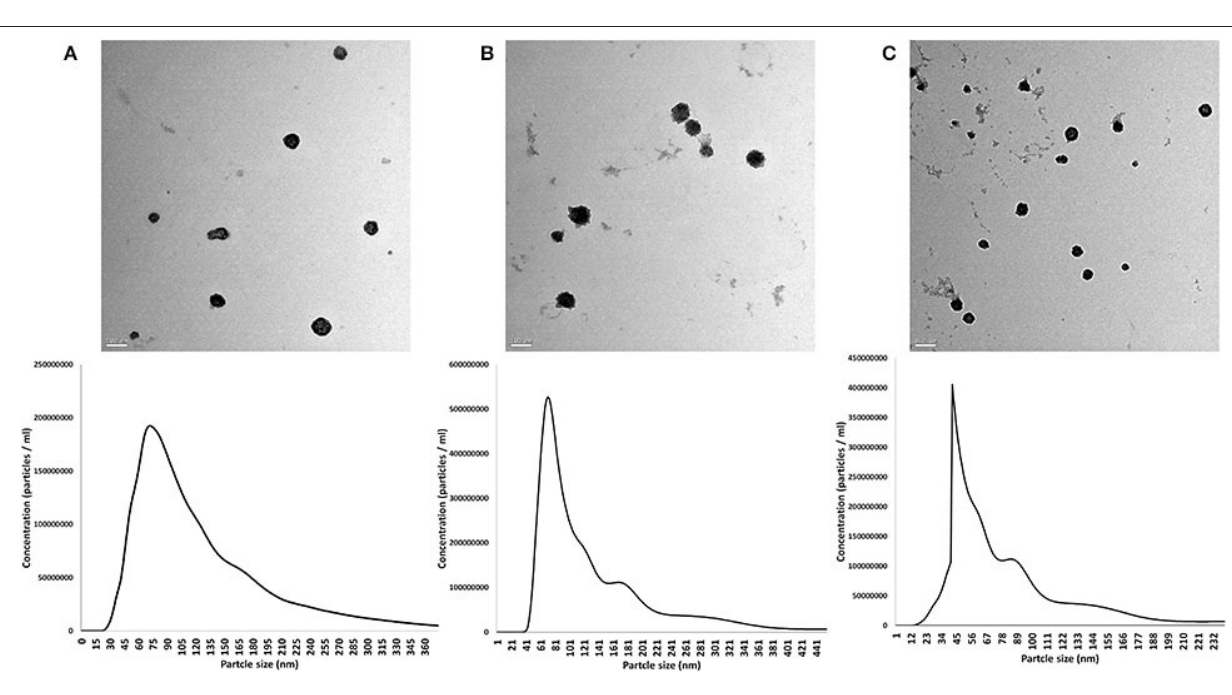
FIGURE 2 | Characterization of extracellular vesicles (EVs) from the rabbit prostate (A) , testis (B) , and epididymis (C) . Upper panel shows the TEM images. Scale bars , 100nm for (A,B) and 200nm for (C) . Lower panel shows the results of nanoparticle tracking analysis (size and concentrations) of the EVs in the corresponding tissue of origin: prostate (A) , testis (B) , and epididymis (C)